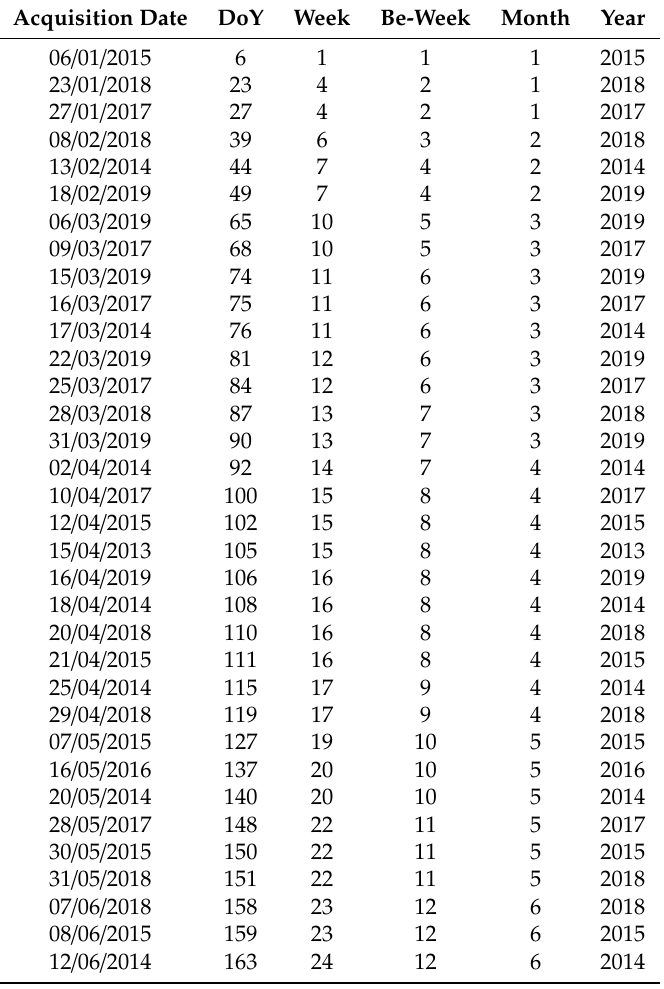
Table A2. Landsat-8 images covering the study area used with the acquisition dates converted into Day of Year (DoY), week, bi-week, and